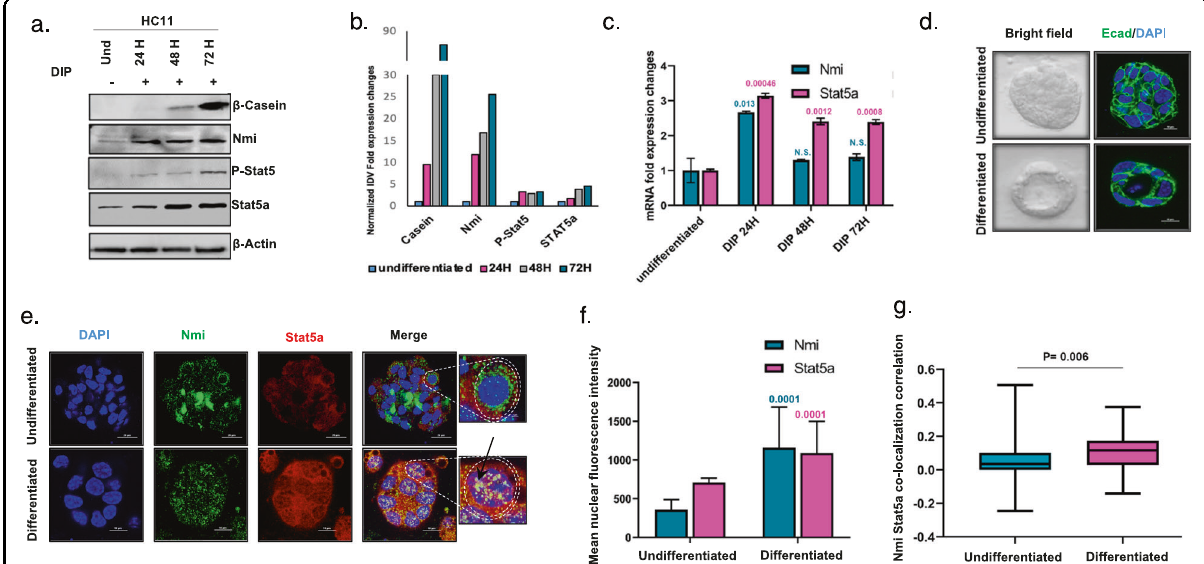
Fig. 2 NMI and STAT5A show concurrent expression pattern and nuclear localization in HC11 mammary cell differentiation. a Western blot for β -Casein, NMI, Phospho-STAT5A, and STAT5A in undifferentiated HC11 cells and during the induction of differentiation using Dexamethasone, Insulin and Prolactin at hours 24, 48, and 72 h from the start of induction. b Normalized integrated density values for western blot signals for β -casein, NMI, P-STAT5A, and STAT5A in HC11 during the course of differentiation. c Fold expression changes of NMI and STAT5A using RTq-PCR in undifferentiated HC11 cells and during the induction of differentiation using Dexamethasone, Insulin, and Prolactin at hours 24, 48, and 72 from the start of induction. d Undifferentiated HC11 cells that were embedded in Matrigel and stimulated by DIP to differentiate into organized mammary acini. Right panel represents bright fi eld images and left panel represents fl uorescence imaging of E-cadherin in green to represent cell-to-cell junction and DAPI staining for nucleus in blue. e Immuno fl uorescence staining for NMI (Green) and STAT5A (red) in undifferentiated and differentiated HC11. DAPI was used to stain the nucleus, magni fi ed pictures represent nuclear translocation of NMI and STAT5A in differentiated cells. f Graph represents mean nuclear fl orescence intensity quanti fi cation of NMI and STAT5A in undifferentiated and differentiated cells. This quantitation was conducted for all cells in the Z-stack of 3D organoid. g Graph represents Nmi and STAT5A colocalization correlation in nuclei of undifferentiated ( n = 20) and differentiated ( n = 15)